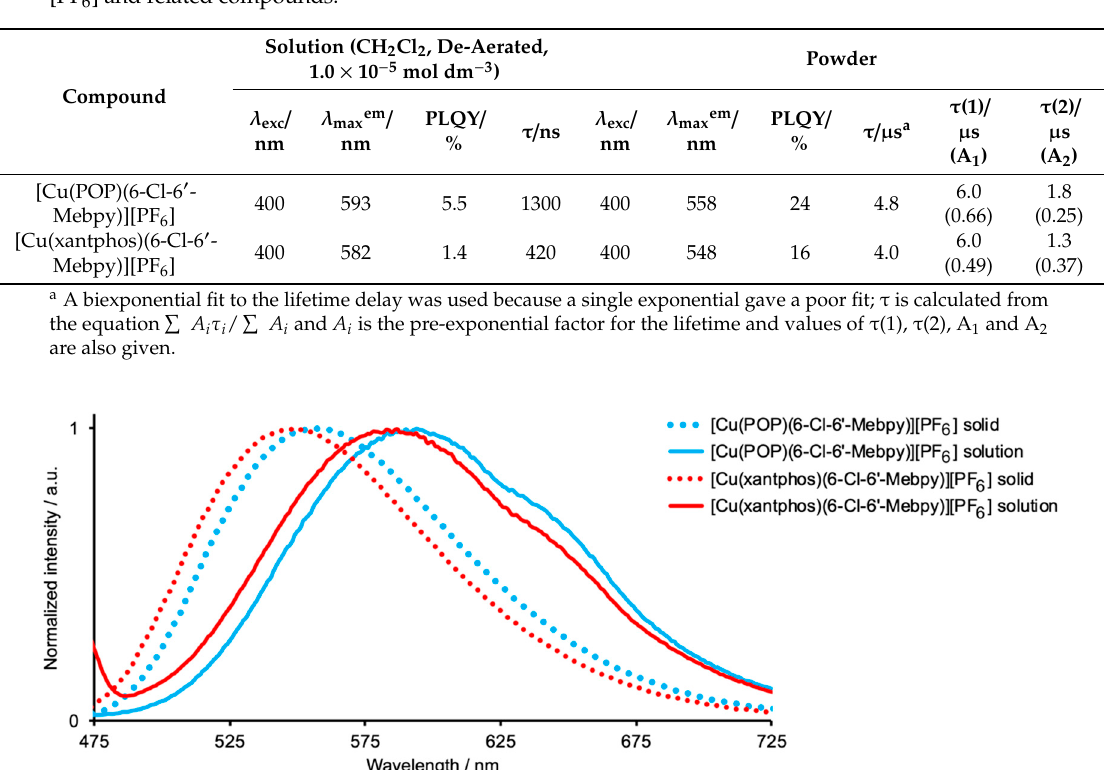
Table 4. Photophysical properties of [Cu(POP)(6-Cl-6’-Mebpy)][PF 6 ] and [Cu(xantphos)(6-Cl-6’-Mebpy)][PF 6 ] and related compounds.